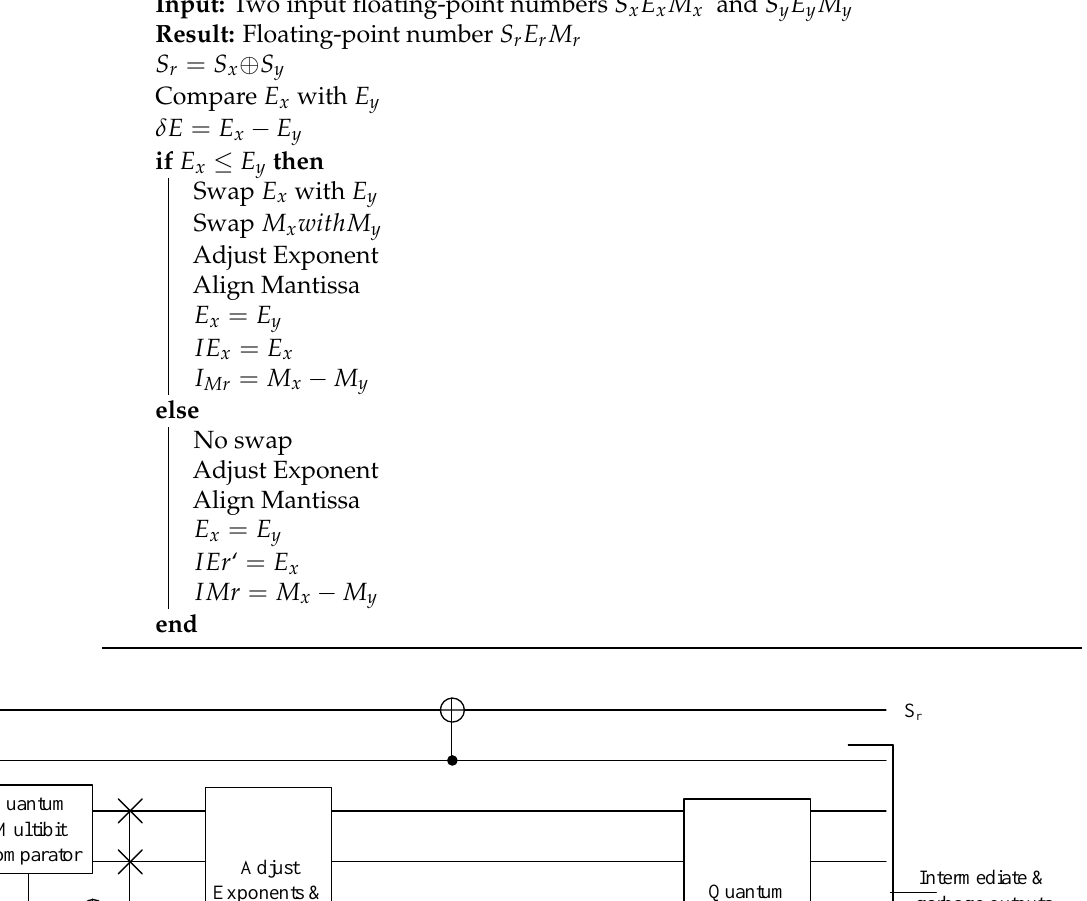
Algorithm 5: Floating-point addition and subtraction algorithm.